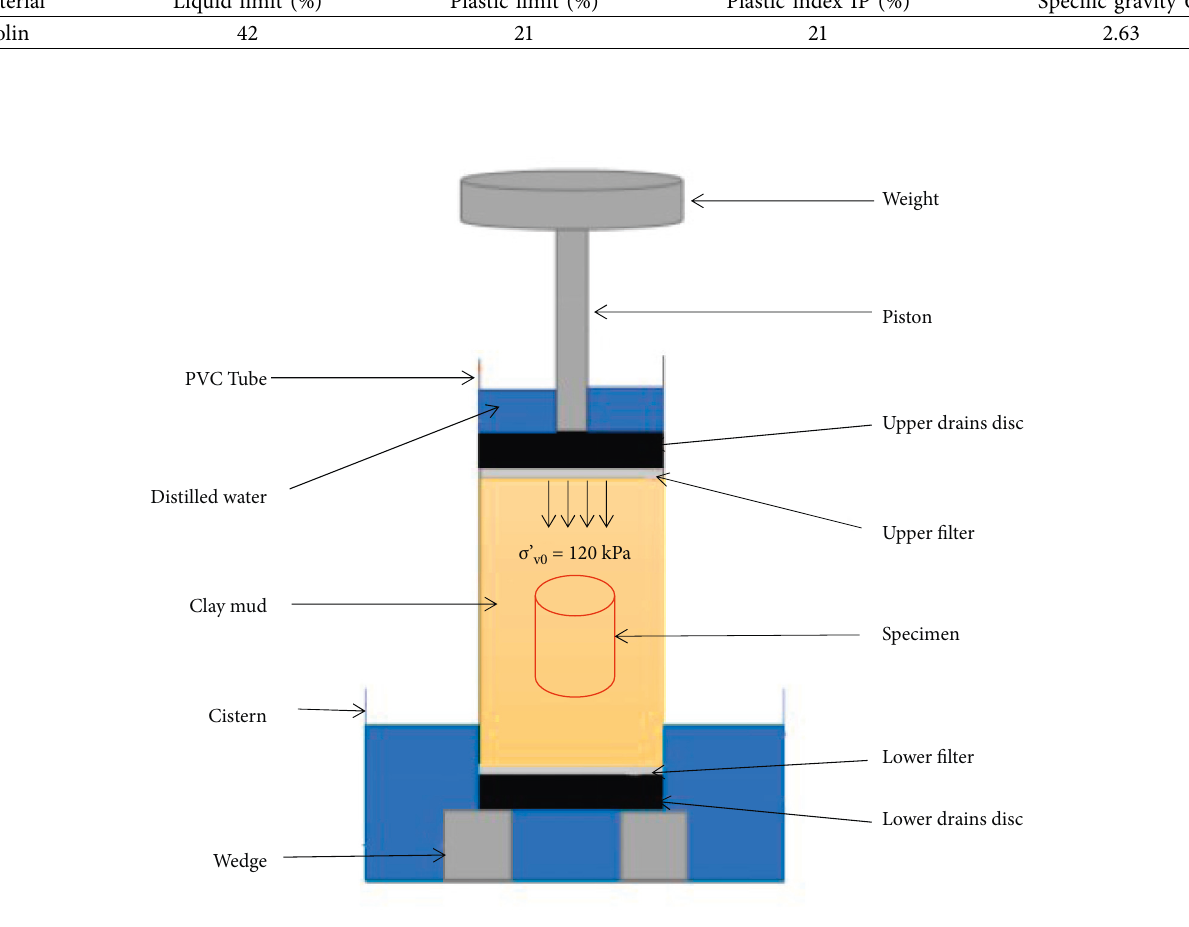
Figure 2: Schematic diagram of consolidometer. Table 2: Initial state parameters of the specimens.